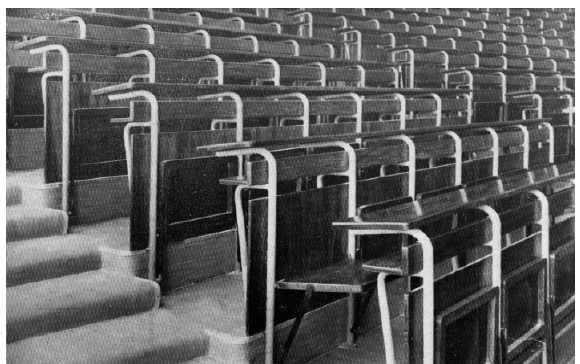
Figure 44. Technical drawing of articulated bench. Image from (De Smaele 1936, p. 20).